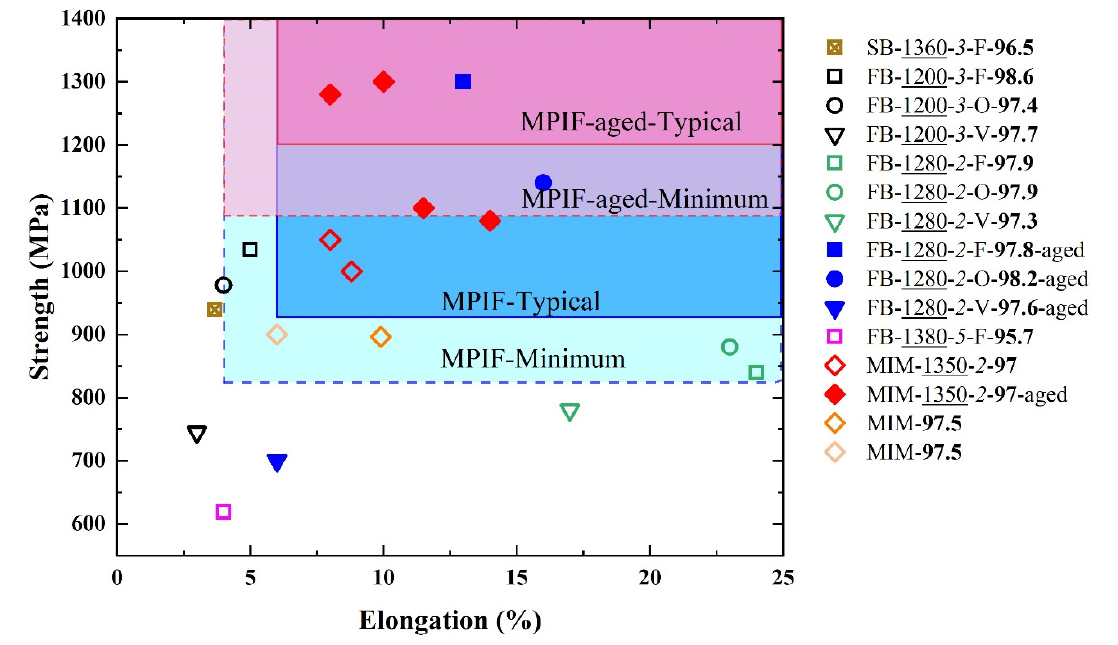
Figure 22. Stress vs. elongation map of 17-4PH stainless steel fabricated by the metal MEX process with different conditions comparing MPIF standard 35 for MIM materials. The underlined number represents sintering temperature (°C), the italic number represents sintering time (h), F, O and V represent flat, on-edge and vertical printing orientations, respectively, and the bold number represents relative sintered density (%). Data from [8,49,64,92,134,157,158,169]. For 316L stainless steel (Figure 23) [9,45,53,56,57,66,68,75,81,93,98,108,160,161,169,